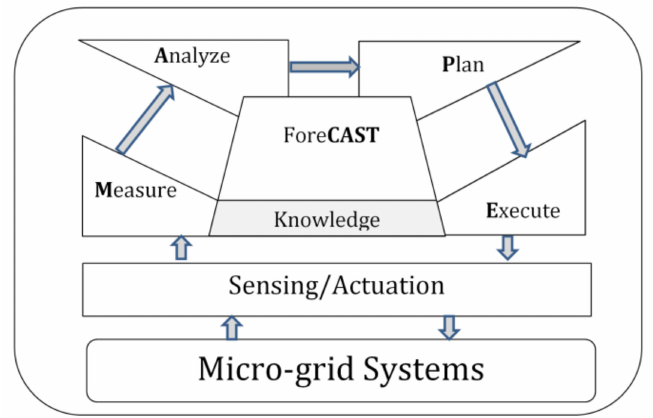
Figure 14. The proposed control approach schemes with operation